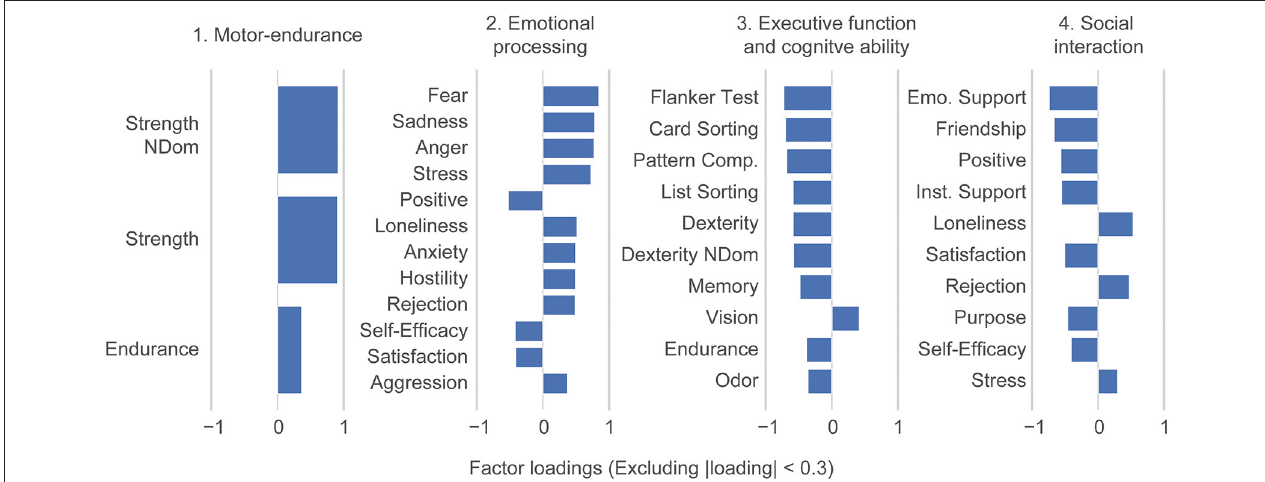
FIGURE 2 | Dimensionality reduction reveals ability traits. Factor loadings in terms of the individual NIH toolbox variables. A factor analysis performed on the 31 individual NIH toolbox variables identified 4 varimax rotated ability traits: (1) Motor-endurance, (2) emotional processing, (3) executive and cognitive function, and (4) social interaction. Loadings smaller than 0.3 are suppressed in the figure. Abbreviations are mapped to NIH toolbox variables in Supplementary Table 4 . The dexterity variables are multiplied by negative one because the original value represents the time to test completion, so greater values indicate worse performance. However, all other variables follow the convention that greater values represent better test